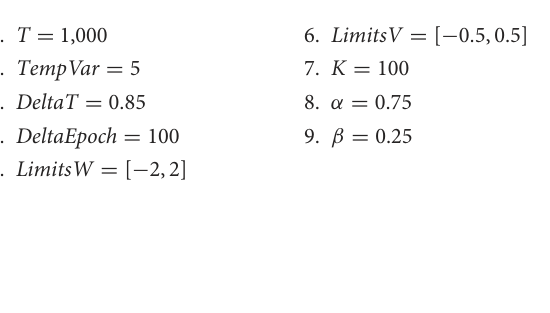
The parameters of the algorithm used in this work are shown